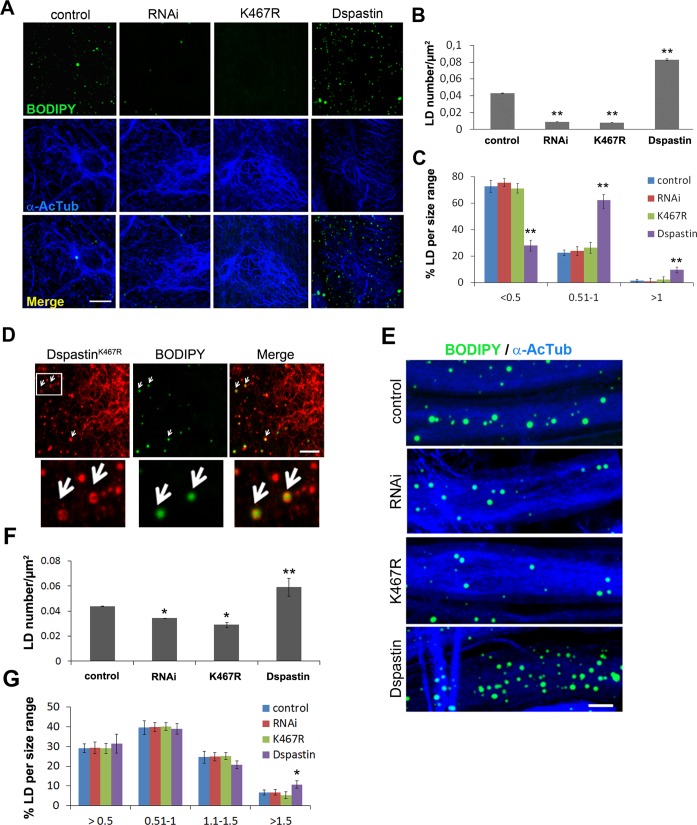
Dspastin dosage affects LD number and size in skeletal muscle and nerves.(A) Representative images of Drosophila larvae muscles labeled with acetylated α-tubulin and BODIPY 493/503. DspastinK467R expression and loss of Dspastin in muscle cells using the Mef2-Gal4 promoter reduced drastically LDs within the tissue. Muscle specific overexpression of Dspastin (Dspastin/Mef2-Gal4) caused increased LD number and size. Control genotype (Mef2-Gal4/+). Scale bar, 10 μm. Quantification of LD number (B) and size distribution (C) in muscles. Significance was calculated using unpaired t-test (two tailed) in B and Mann-Whitney test in C. Differences were considered statistically significant at p<0.05 (*) and p<0.005 (**). (D) Drosophila larval muscle expressing myc-tagged DspastinK467R was labeled with an anti-myc antibody and LDs with BODIPY 493/503. White arrows show LD localization of DspastinK467R. Scale bar, 5 μm. (E) Maximum intensity projections of proximal ventral ganglion nerves from Drosophila third instar larvae expressing Dspastin, DspastinK467R, DspastinRNAi under the neuronal driver Elav-Gal4 and controls (Elav-Gal4/+). Nerves were labeled with acetylated α-tubulin to visualize stable MTs and BODIPY 493/503 to detect LDs. Nerves overexpressing wild-type Dspastin show increased LD size and number, whereas Dspastin downregulation (DspastinRNAi/Elav-Gal4) and DspastinK467R expression (DspastinK467R/Elav-Gal4) resulted in a loss of LDs. Scale bar, 10 μm. Quantification of LD number (F) and size distribution (G) in nerves. Significance was calculated using unpaired t-test (two tailed) in F and Mann-Whitney test in G.